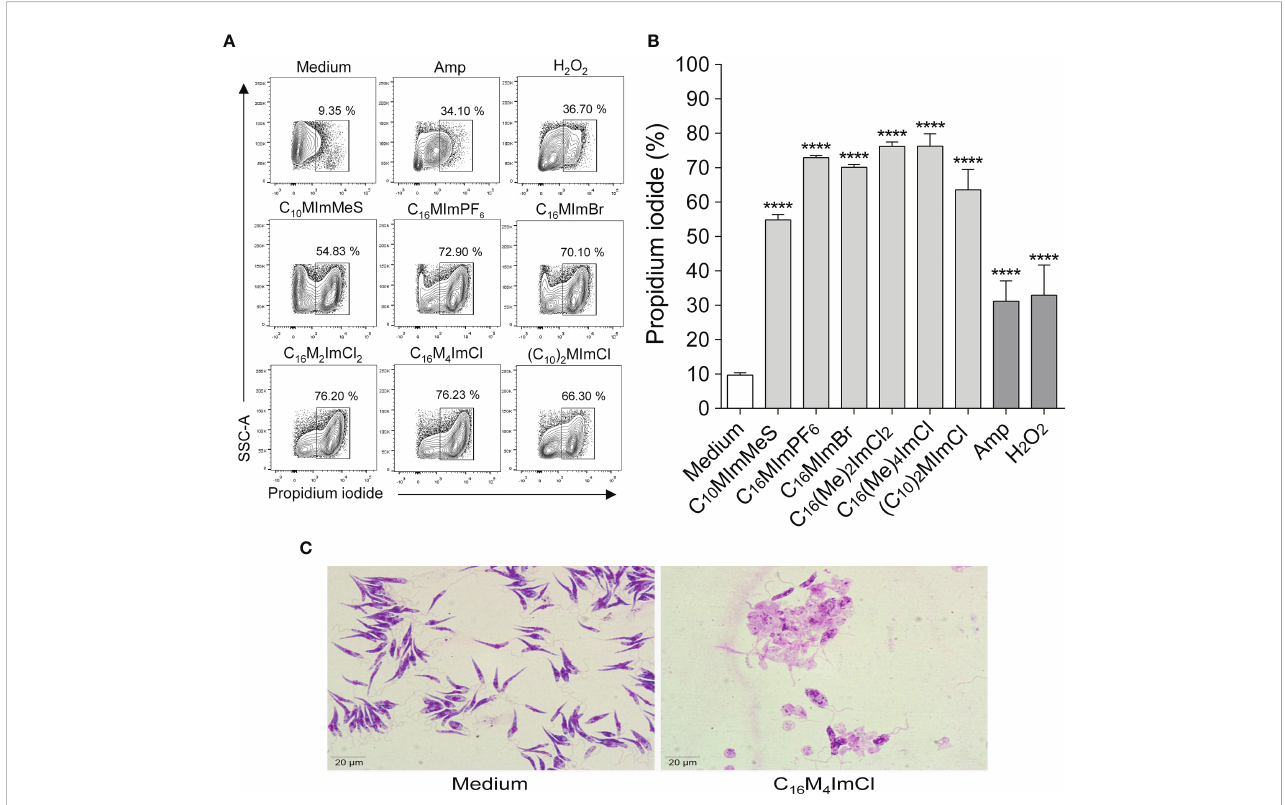
FIGURE 4 Determination of membrane integrity of L. amazonensis promastigotes treated with imidazolium salts (A, B) . Promastigote forms in the logarithmic phase (2 x 10 5 cells/well) were incubated or not with 2-fold IC 50 value of IS for 48 h at 26°C. M199 was used as negative control, and amphotericin B (0.4 µM) or H 2 O 2 (2 mM) as positive controls. Data are expressed as means ± SEM (n = 5) and are representative of three independent experiments. The One-way ANOVA test followed by the Bonferroni ’ s test were applied. ****p < 0.0001 when compare with the medium group. (C) L. amazonensis integrity after 48 h of exposure to C 16 M 4 ImCl at 1.8 m M or M199 (panoptic stain – 1000 × magni fi